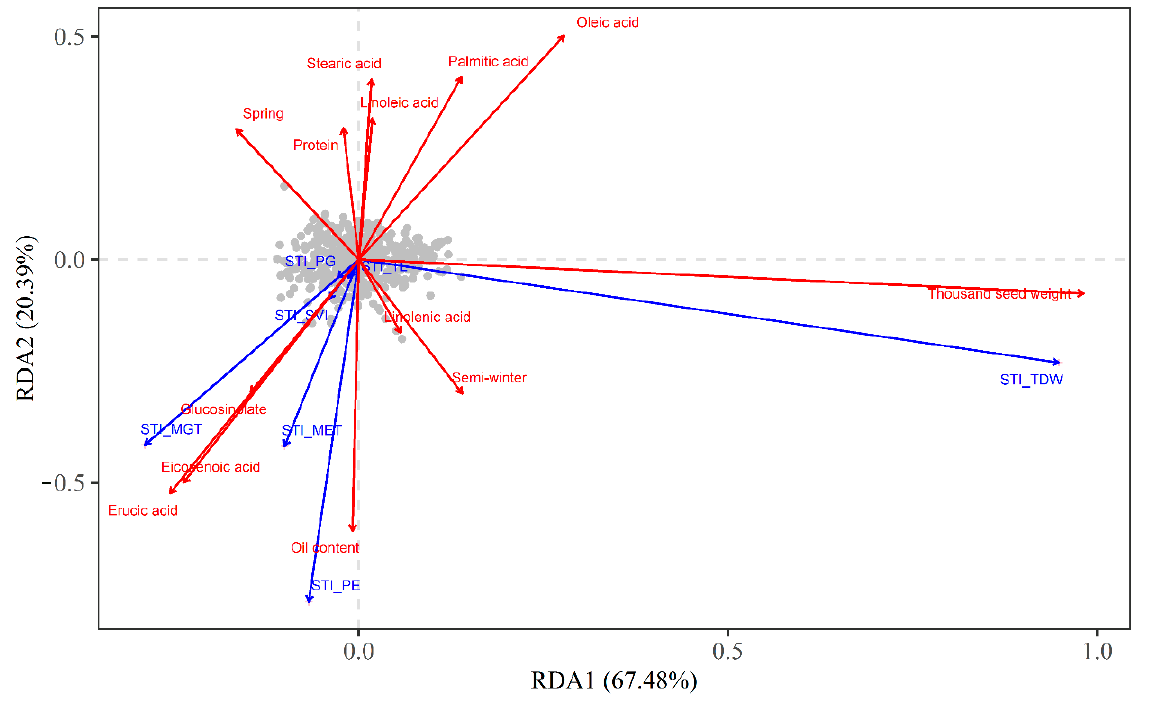
Figure 5. Schematic representations of a triplot-based redundancy analysis. Red arrows indicate explanatory variables, namely seed traits; blue arrows indicate the response variable, namely the low-temperature stress tolerance index related to seed germination and seedling emergence. The grey points represent genotype varieties.